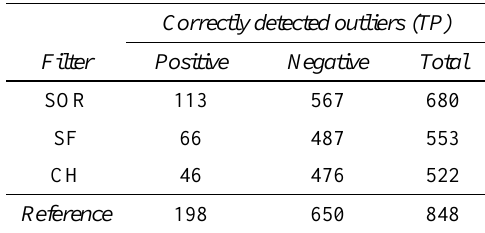
Table 2. Positive and negative outlier distribution